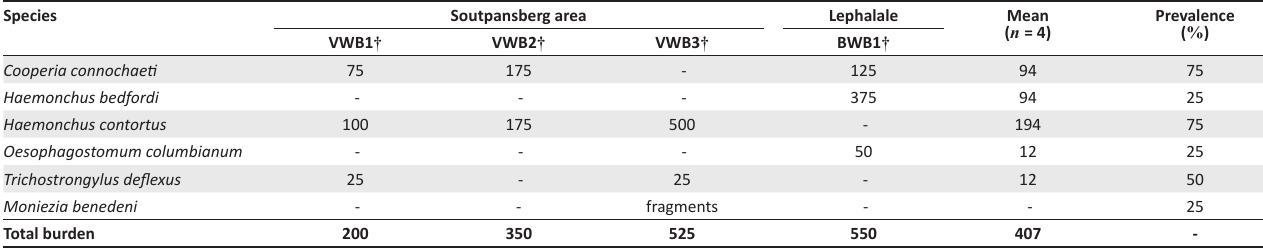
TABLE 4: Total helminth burdens of examined blue wildebeest.